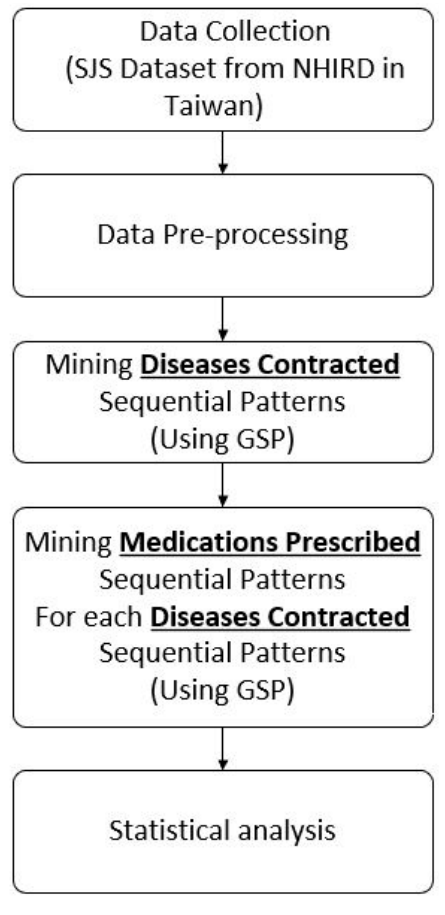
Figure 1. Research framework.